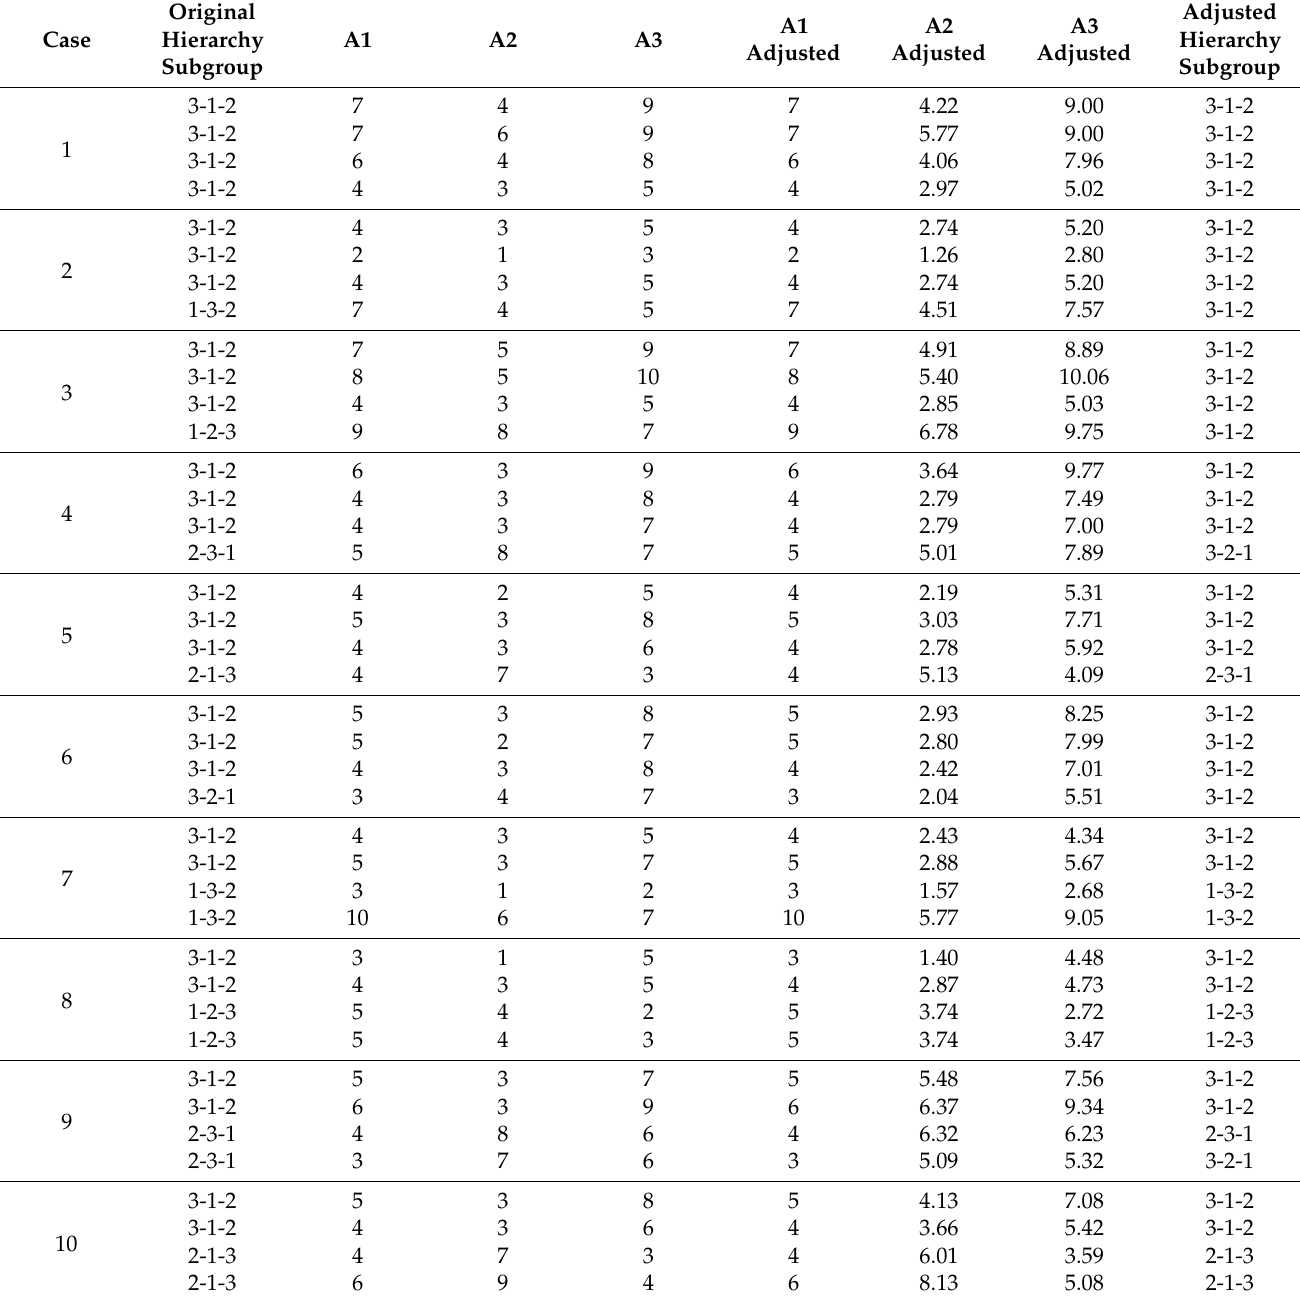
Table 5. Original and optimized test case results for a